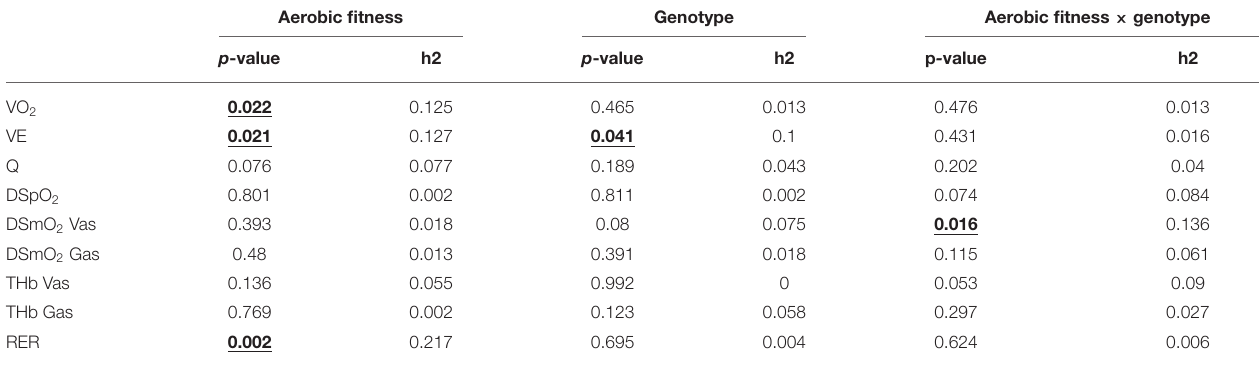
TABLE 4 | Association of fitness state × genotype with the slopes between metabolic parameters and power output. Aerobic fitness Genotype Aerobic fitness × genotype p -value